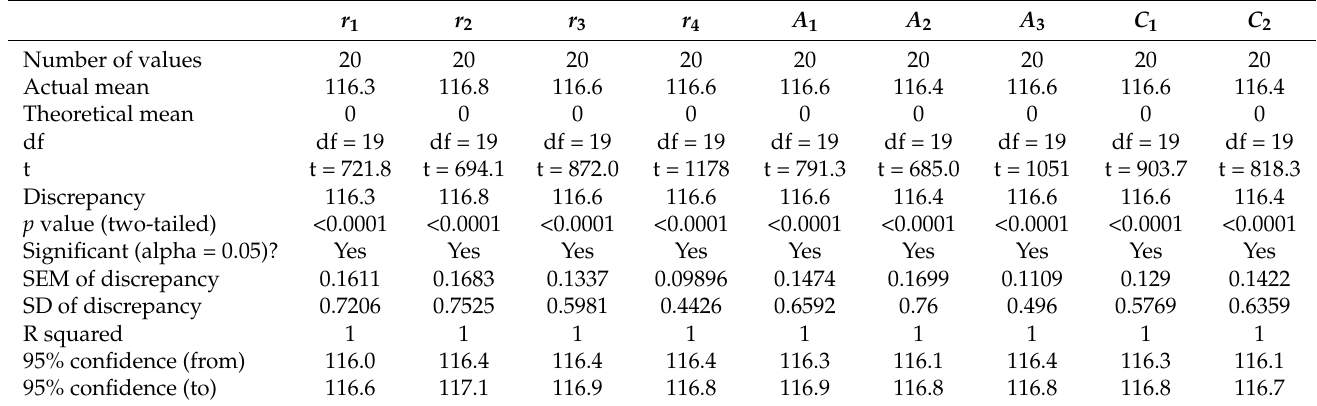
Table 20. Wilcoxon signed-rank test of the fitness of the proposed ADSCFGWO algorithm.